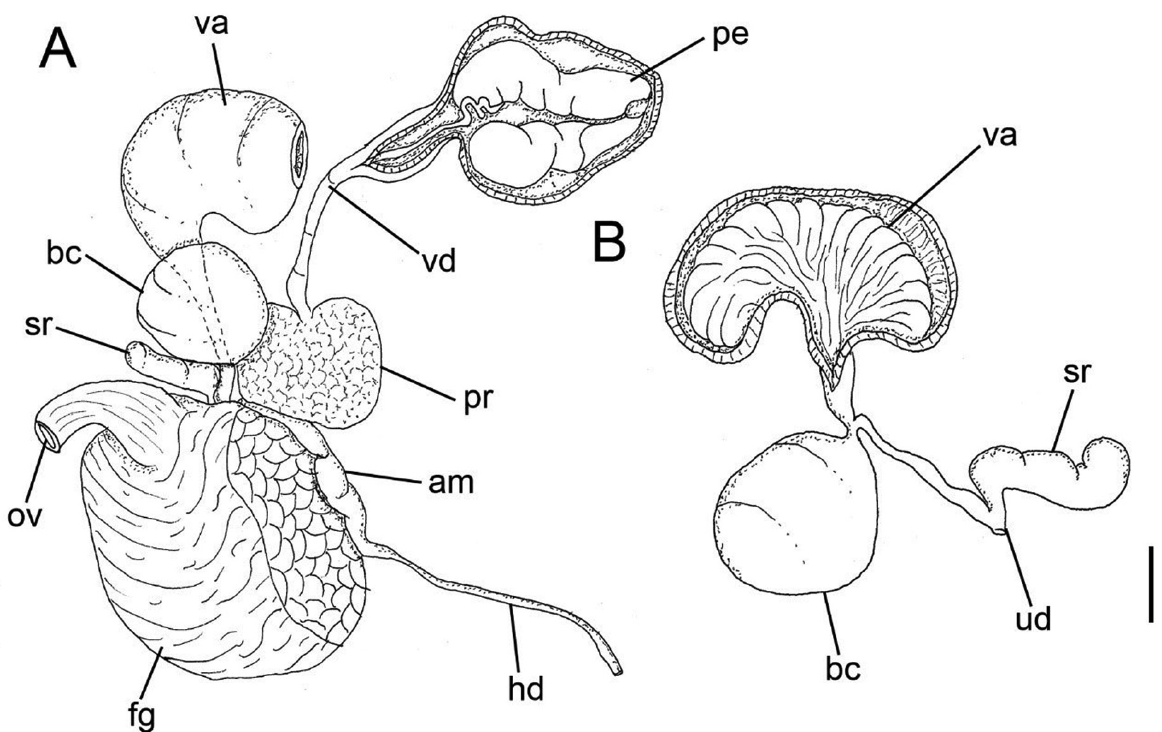
Figure 10. Platydoris guarani . Reproductive system A general ventral view B detail of Bursa copulatrix, seminal re- ceptacle, uterine duct and vagina. Scale bars: 2